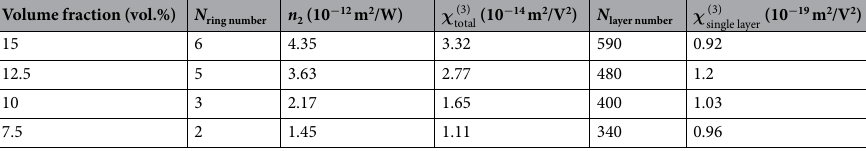
Table 1. The sample concentration and nonlinear optical parameters.